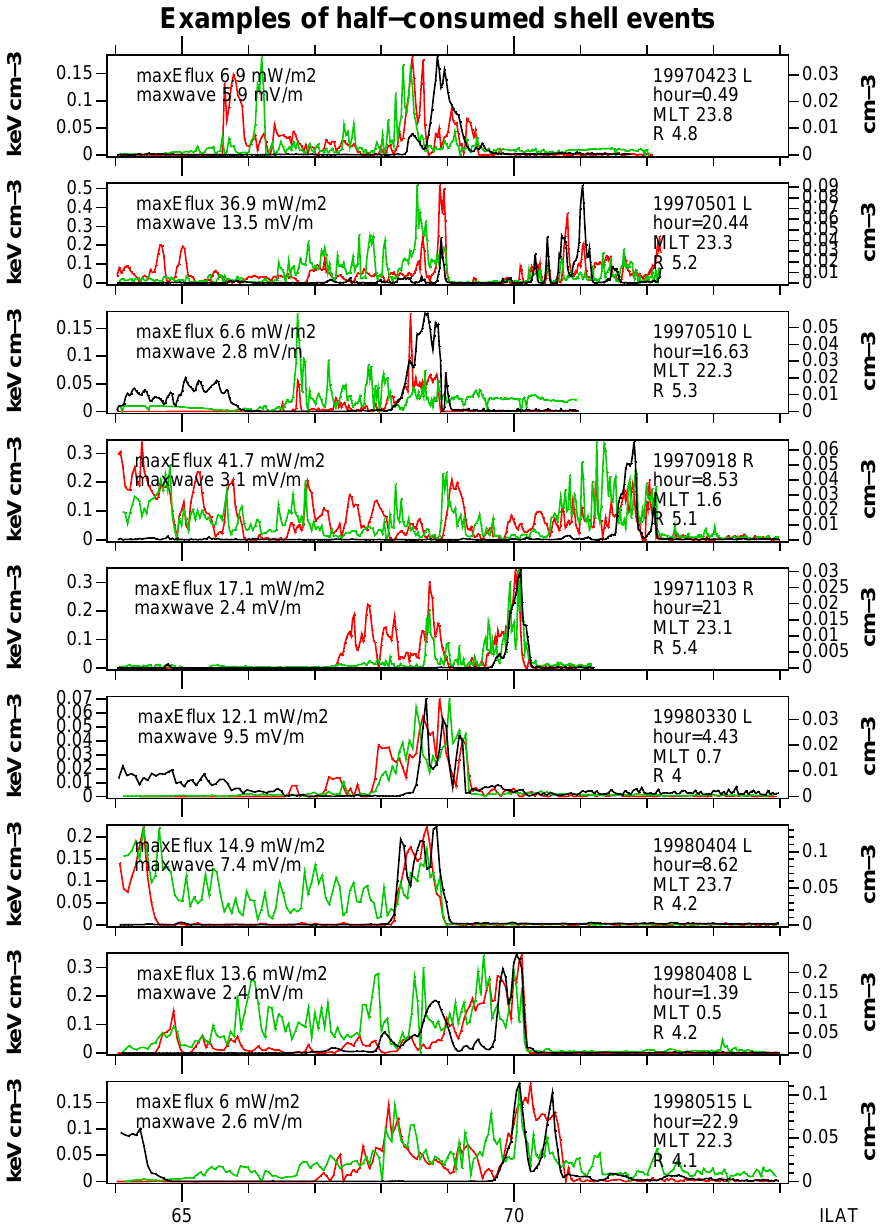
Fig. 14. Examples of half-consumed shell events. Each panel is one event. Black line is free energy from TIMAS (scale on the left) and red line is magnitude of electron anisotropy from HYDRA (scale on the right). Green line is unnormalised perpendicular wave power from EFI (12-s averaged); its attained maximum is written on the left (“maxwave”). Maximum downward ion energy flux from TIMAS during time when free energy exceeds 0.02keVcm − 3 is also given; the value is given at the ionospheric level by multiplying the measured value by flux tube scaling factor. Event date and average UT-hour, MLT and radial distance are also given. The letter L(R) after the date indicates that the satellite is moving to the left (right), i.e. towards decreasing (increasing)